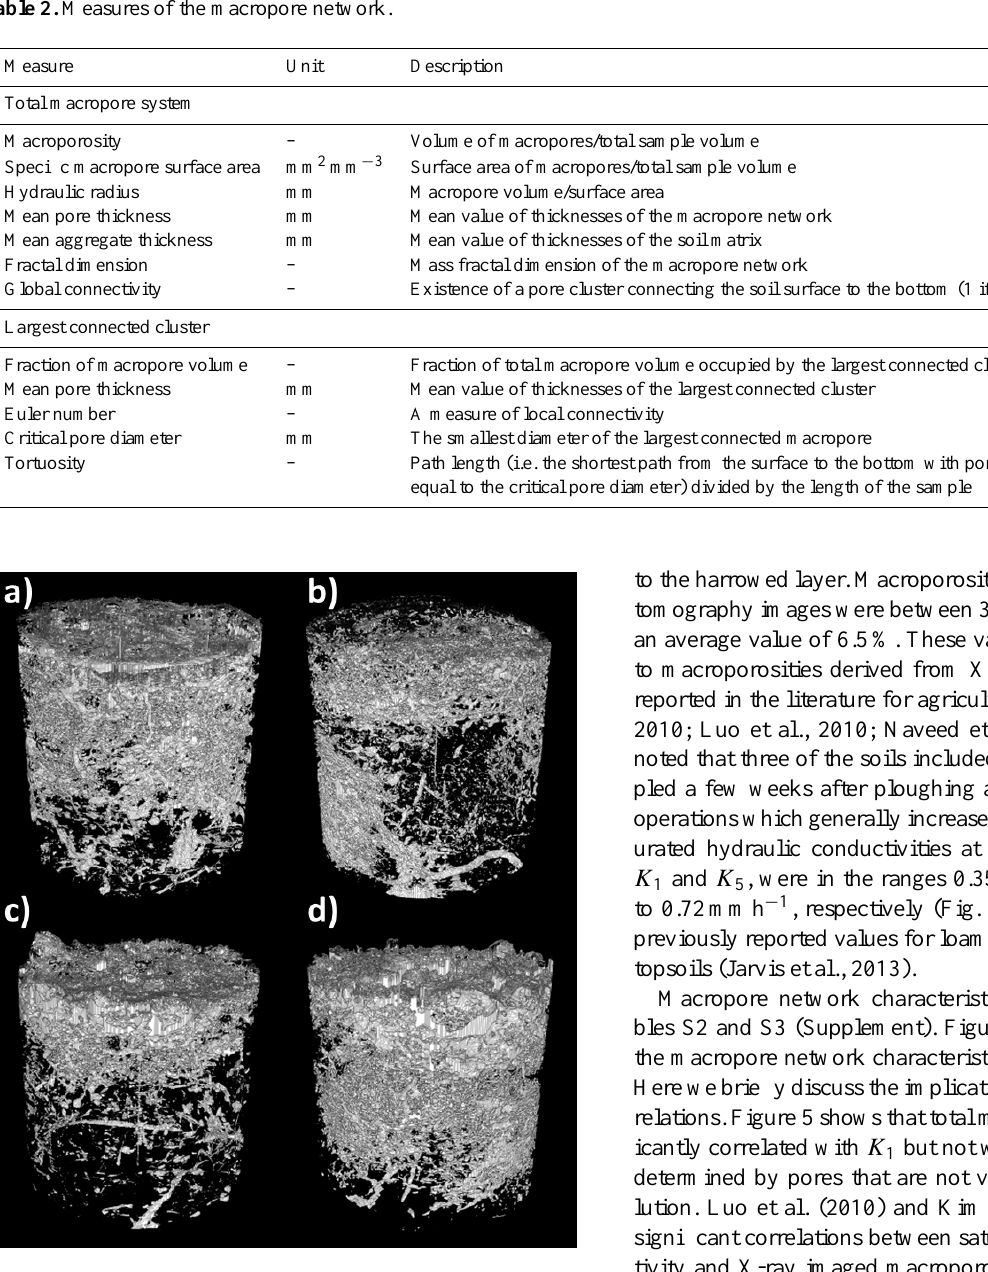
Table 2. Measures of the macropore network.